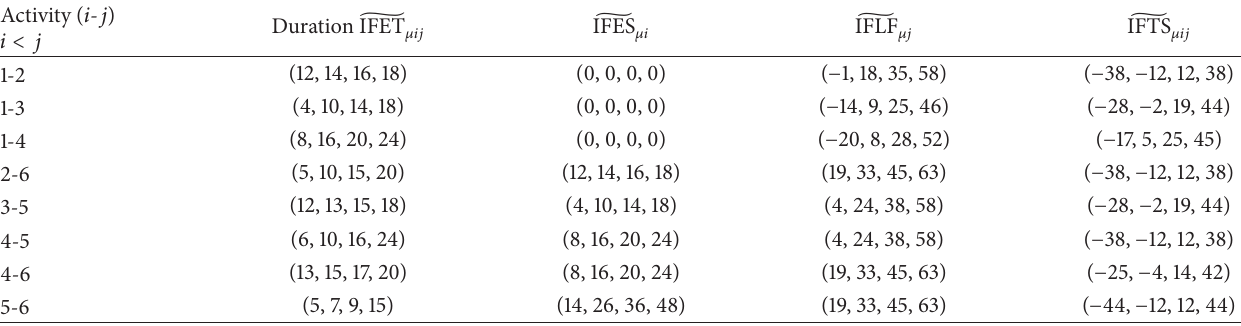
Table 2: Total slack (Atanassov) intuitionistic fuzzy time for each activity in an (Atanassov) intuitionistic fuzzy project network and critical path for membership function.